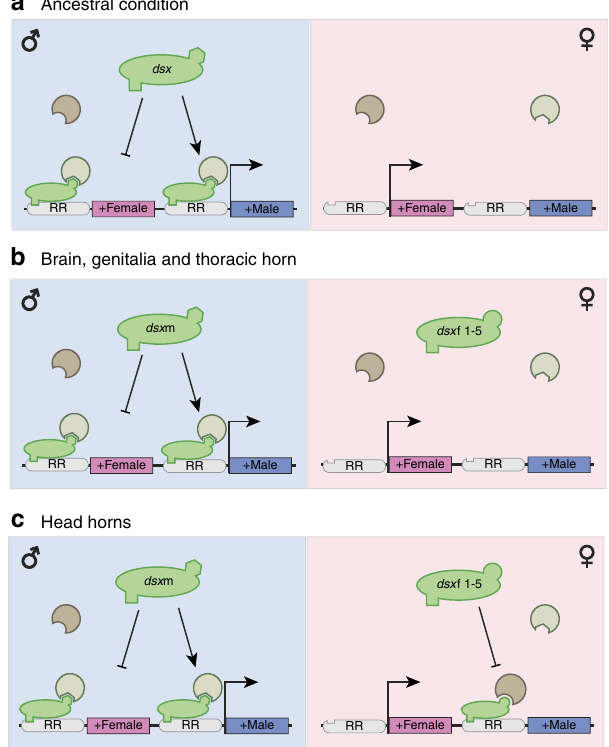
Figure 4 | Dsx asymmetrically directs sex- and tissue-specific gene expression in most O. taurus tissues, but acts as a genetic switch in head horns, a recently evolved and sexually selected trait. ( a ) In non-insect arthropods retaining the putative ancestral condition, Dsx possesses only a single isoform, and contributes mostly to the masculinisation of male tissues (left, blue background) by promoting masculinising genes ( þ male boxes) and suppressing feminising genes ( þ female boxes), but has no role in female-specific differentiation (right, pink background). ( b ) In insects, Dsx is alternately spliced into male- and female-specific isoforms. In O. taurus , the species addressed in this study, Dsx acts as a sex-specific modulator in several tissues (brain, genitalia and thoracic horns), such that the target gene repertoires of female and male isoforms are largely independent. Further, although females express feminising genes across these tissues, the female Dsx isoforms do not have a large role in mediating such expression. The ability of male and female isoforms to target different gene repertoires in spite of identical DNA-binding domains is the result of either differential presence of cofactors between sexes (not pictured) or the different interactions with cofactors that arise from the different C-terminal oligomerization domains of the male and female isoforms (pictured). In addition, although the target gene repertoires of female and male also suppress the expression of feminising genes in males, even when